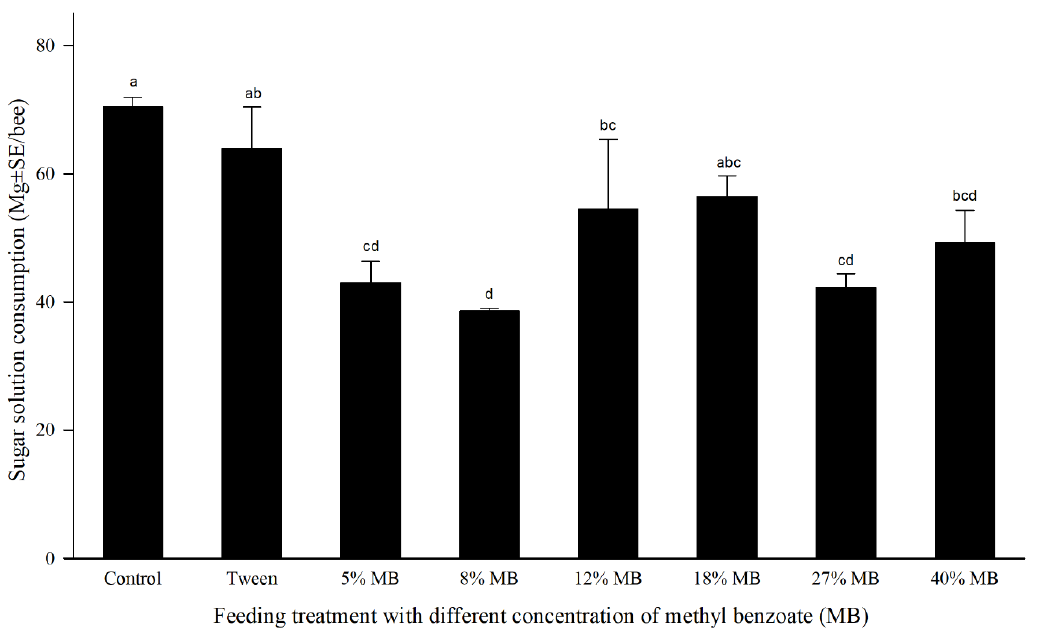
Figure 3. Influence of methyl benzoate (MB) on honey bee feeding. Sugar solution consumptions were calculated based on number of live bees averaged between 0 and 48 h after treatment. Mean bars with the same letters at the top of error bars indicate no significant difference between treatments ( p > 0.05). Insects 2019 , 10 , x